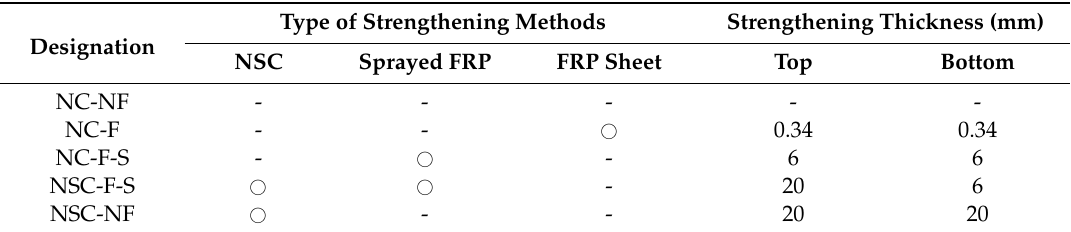
Table 5. Designation and specifications of the test specimens.